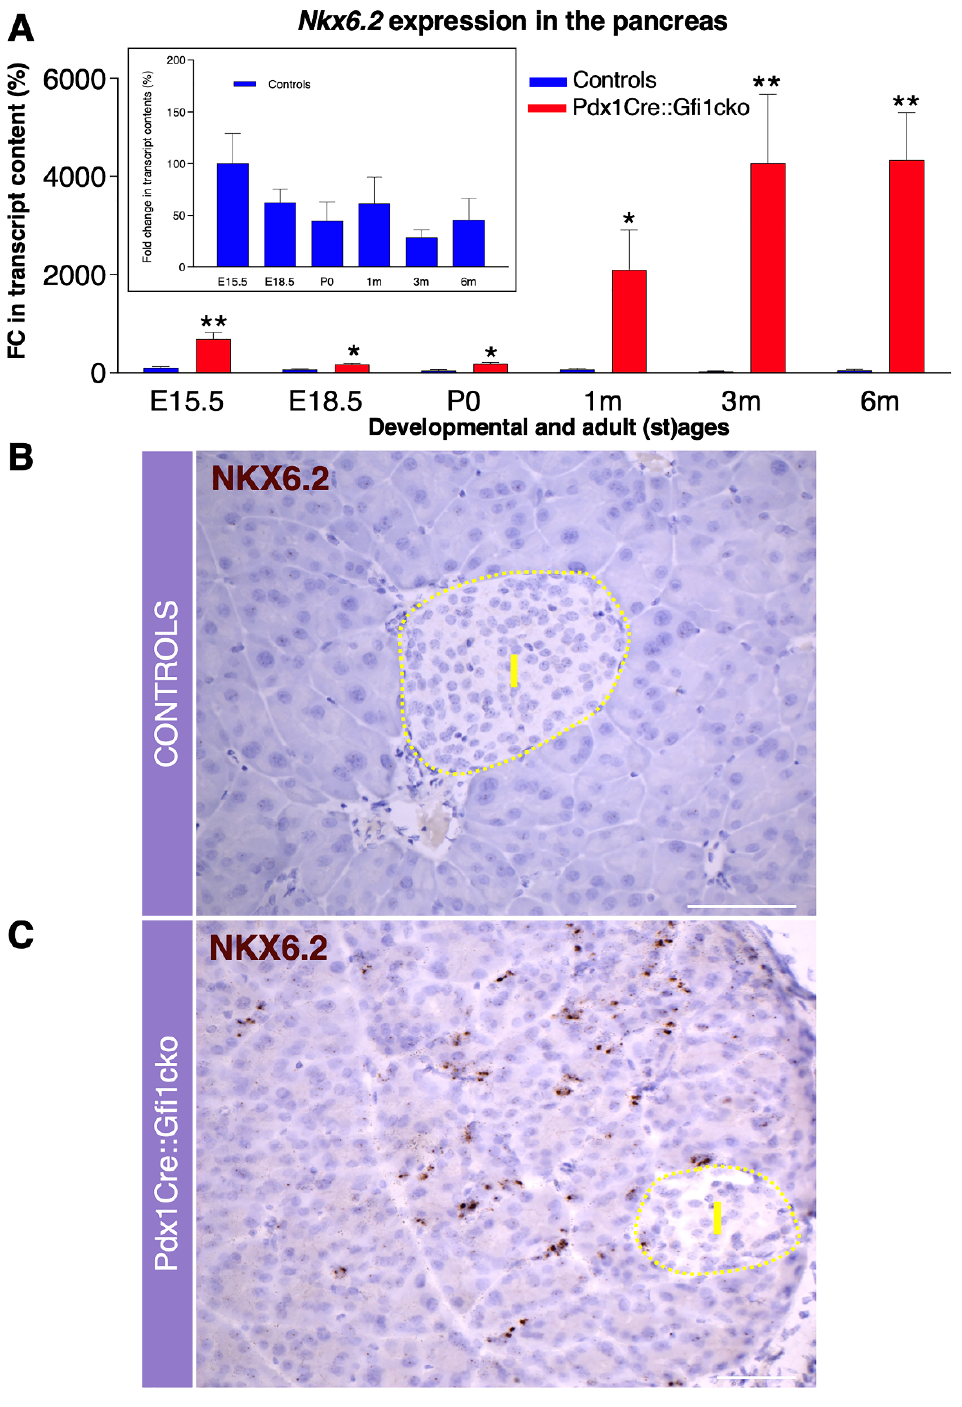
Figure 5. Gfi1 is crucially involved in the regulation of Nkx6.2 expression in mouse pancreas. Expression levels of Nkx6.2 measured by RT-qPCR during the embryonic development and adulthood in the pancreas of Pdx1Cre::Gfi1cko animals and age-matched controls ( n = 5 animals per genotype per (st) age). Insert graph shows Nkx6.2 expression exclusively in control pancreatic samples. (* p < 0.05, ** p < 0.01) ( A ). Nkx6.2 expression pattern was assessed by RNA scope in adult Gfi1 loss of function and control pancreatic sections. Yellow dash line indicates the islet compartment. Objective magnification: 25×. Scale bar: 50 μ m ( B , C ).